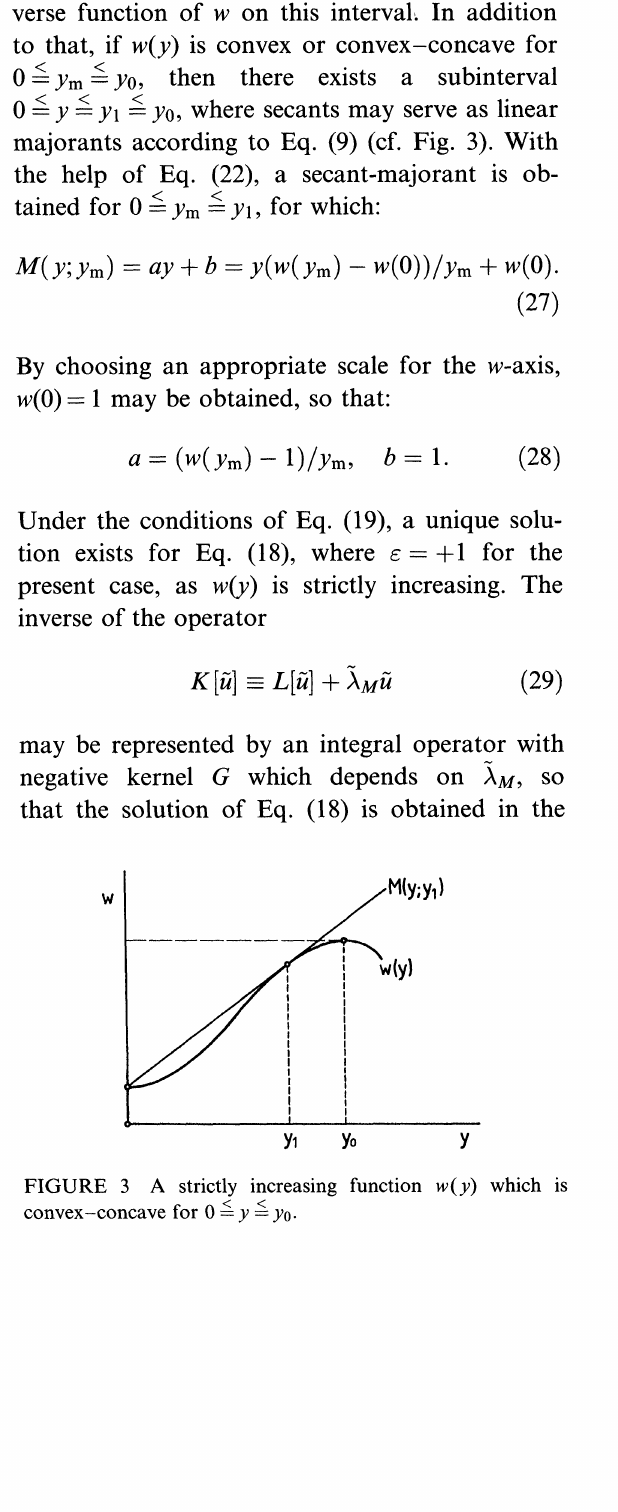
FIGURE 2 An example of a majorant M(y; Ym) of the func- tion w(y) for 0 < < y --ymo